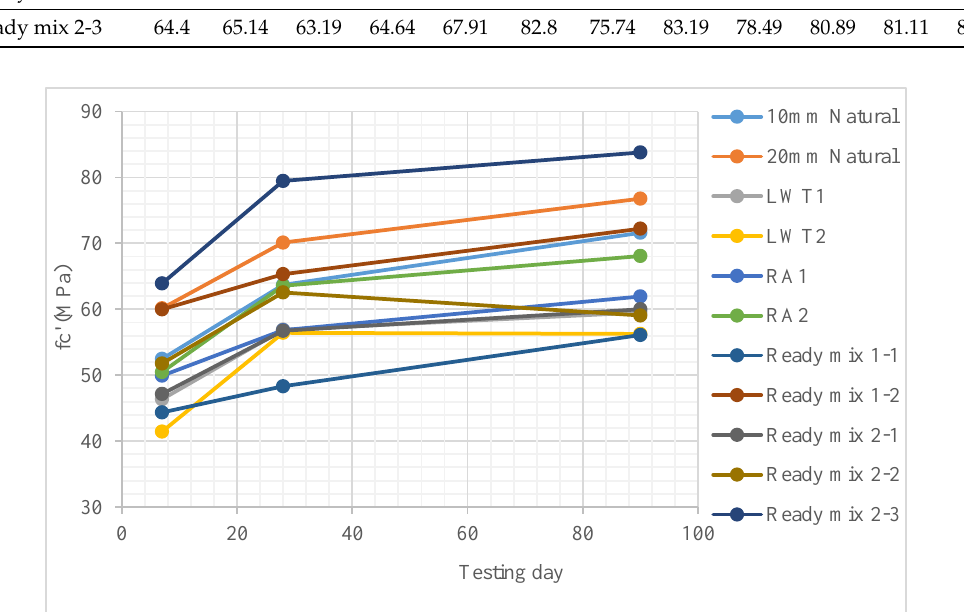
Figure 3. Average cube compressive strength. Crystals 2020 , 10 , x FOR PEER REVIEW